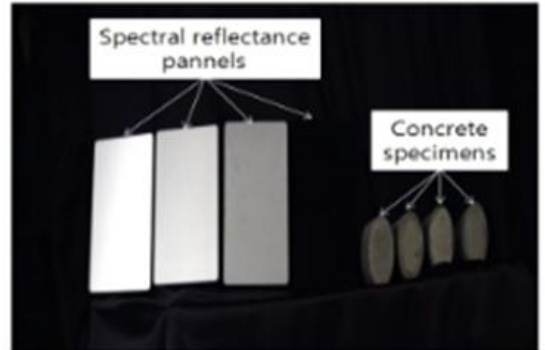
Figure 6. VNIR sensor image